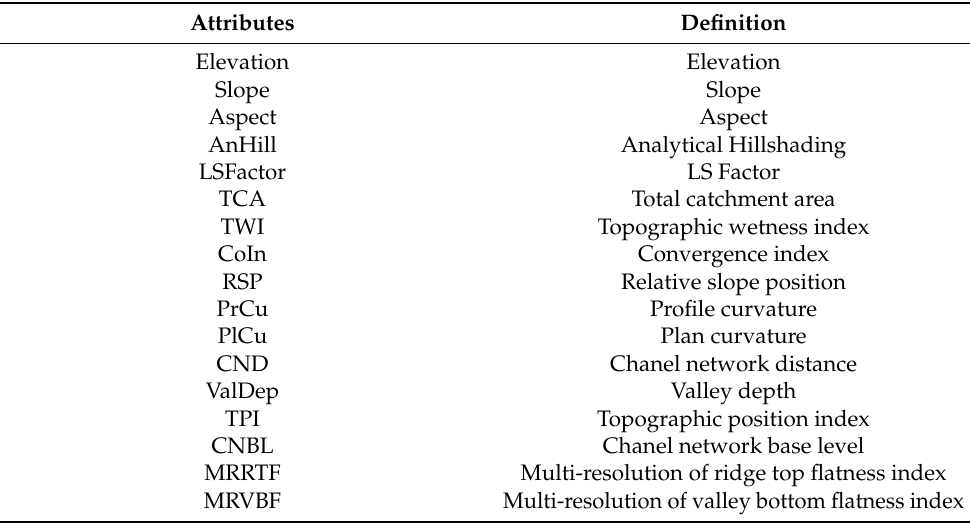
Table 2. Terrain attributes derived from Digital Elevation Model